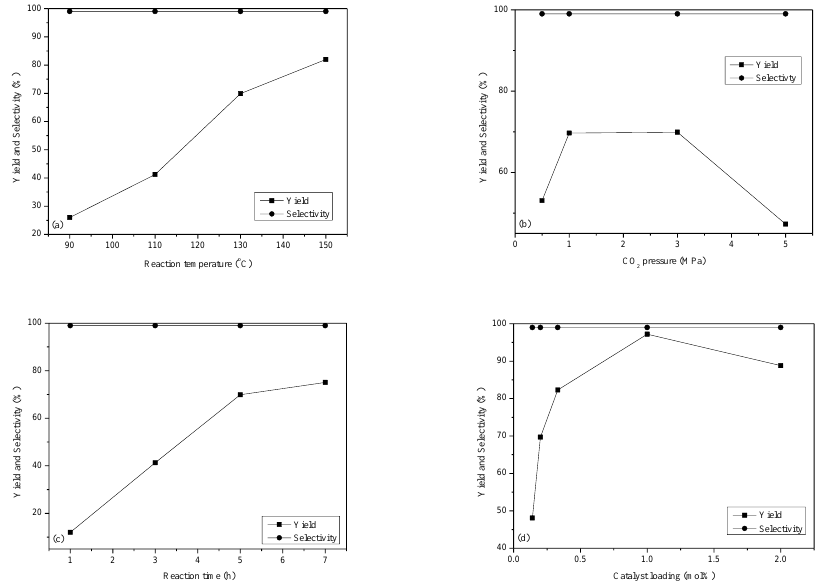
Figure 1. Effects of different reaction parameters on PC yield over Am-CD1-I: ( a ) Effects of reaction temperature, conditions: PO (5 mL, 71.5 mmol), Am-CD1-I (0.2 mol%), CO 2 pressure 3 MPa, time 5 h; ( b ) Effects of CO 2 pressure, conditions: PO (5 mL, 71.5 mmol), Am-CD1-I (0.2 mol%), reaction temperature 130 ◦ C, time 5 h. ( c ) Effects of reaction time, conditions: PO (5 mL, 71.5 mmol), Am-CD1-I (0.2 mol%), reaction time 130 ◦ C, CO 2 pressure 3 MPa. ( d ) Effects of catalyst loading, conditions: PO (5 mL, 71.5 mmol), reaction time 130 ◦ C, CO 2 pressure 3 MPa, reaction time 5 h.